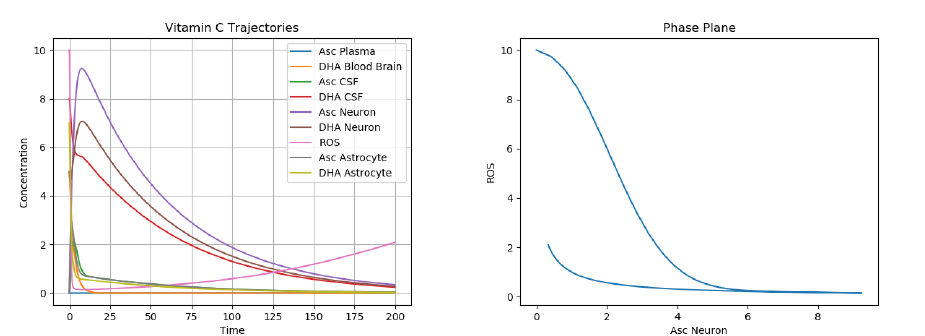
Figure 3. Dynamics of AA, DHA, and ROS during a Stroke